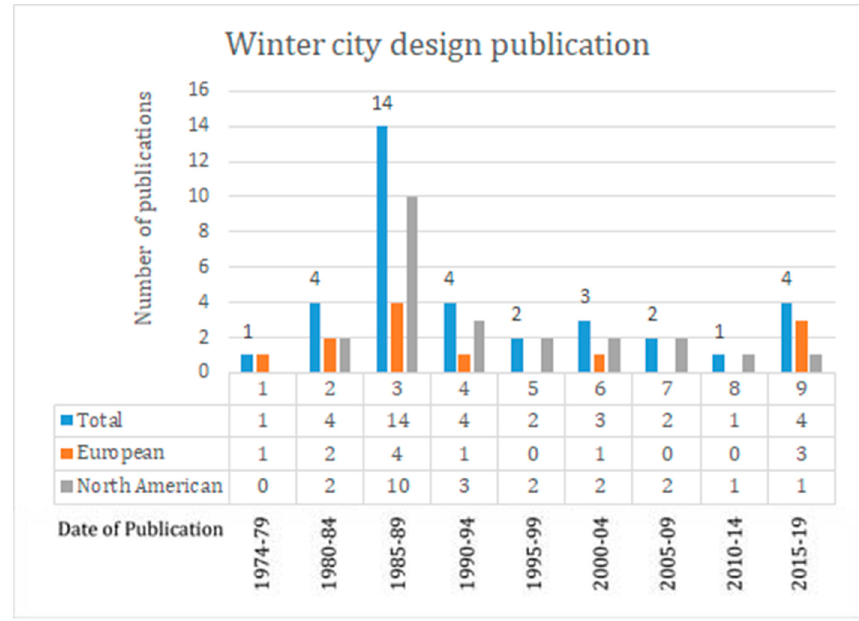
Figure 2. Chronology and geographical origin of the 35 publications included in the literature review.